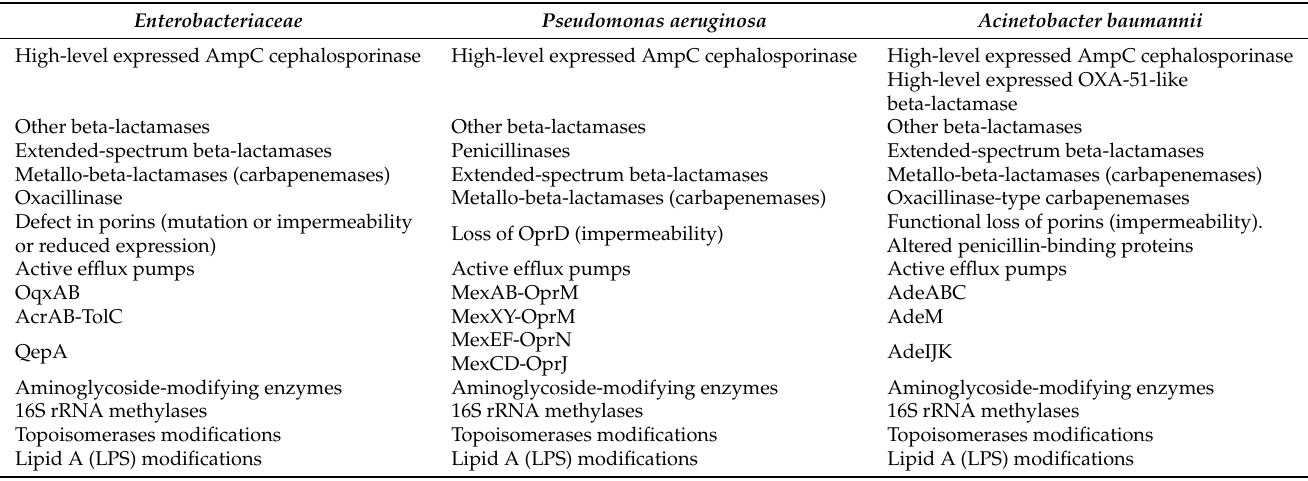
Table 2. Antibiotic resistance mechanism employed by major Gram-negative bacteria (Adapted from Rupp é et al., 2015, [41] and